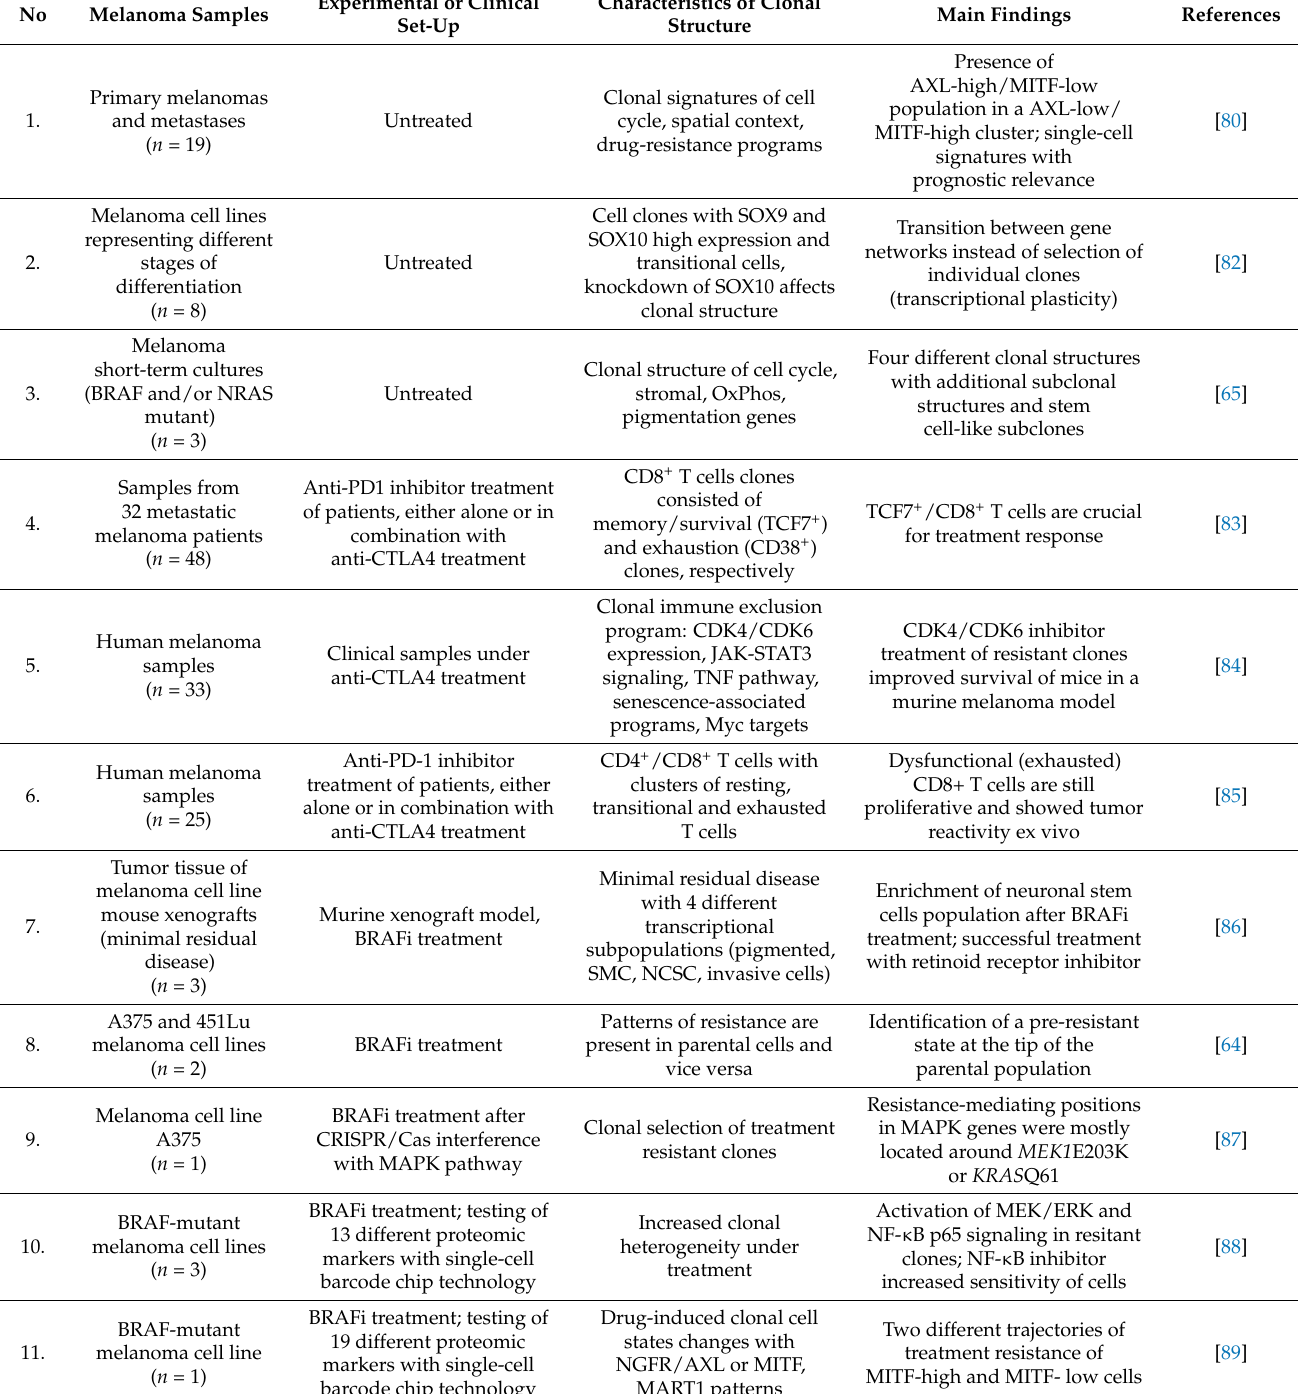
Table 1. Summary of single-cell melanoma transcriptomics and proteomics studies and main